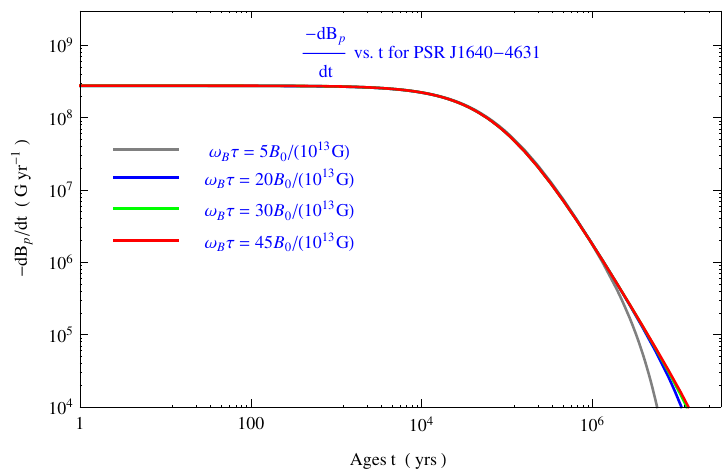
Figure 6. The dipolar magnetic field decay rate dB p / dt as a function of t for PSR J1640-4631 with n >